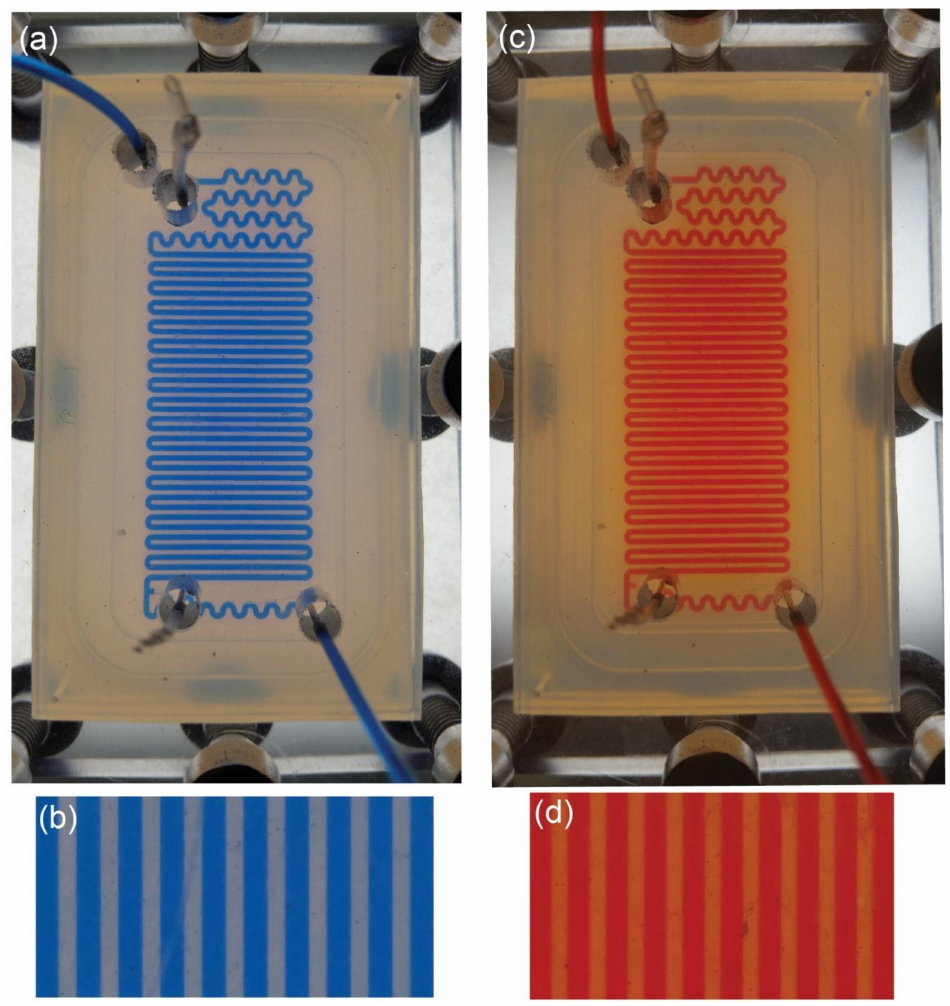
Figure 4. Visualization of the flow of EtOH with Oil Blue ( a , b ) and PrOH with Red Oil ( c , d ) in the photoreactor made of FEP. The photoreactor is placed between the holder made of 10 mm PC plates and compressed with M6 screws (visible at the edges of the pictures a and c ). The flow of the organic solvents is 3 mL · h − 1 which is typical for organic synthesis in microscale. There is no outflow of EtOH or PrOH outside the chip or to the mortise. The light color between main channels is a result of a thin layer of solvents between the two FEP plates (pictures b and d ) due to capillary